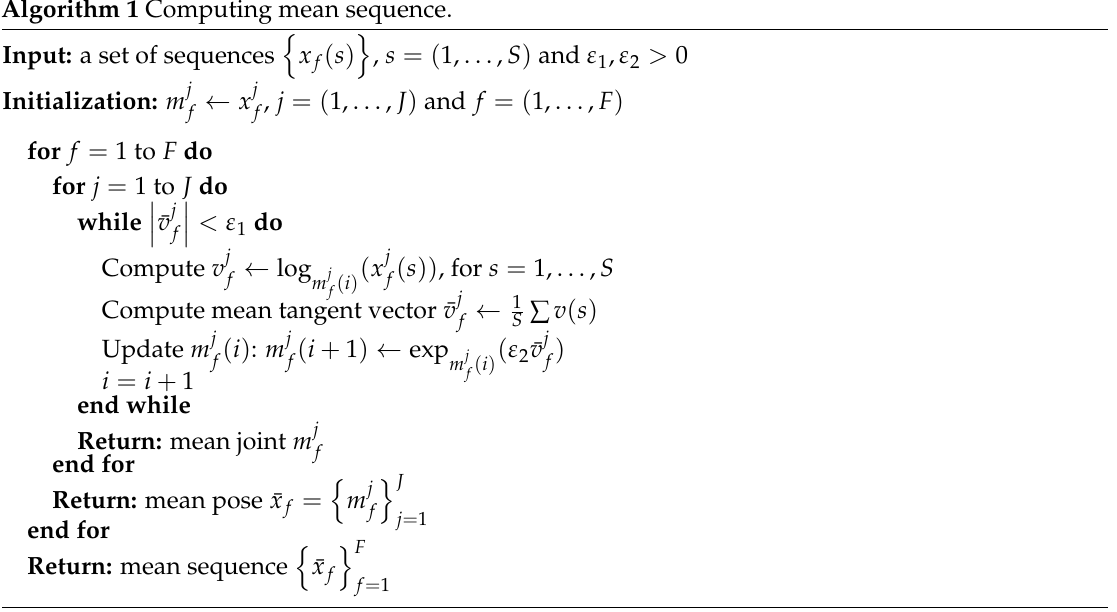
Algorithm 1 Computing mean